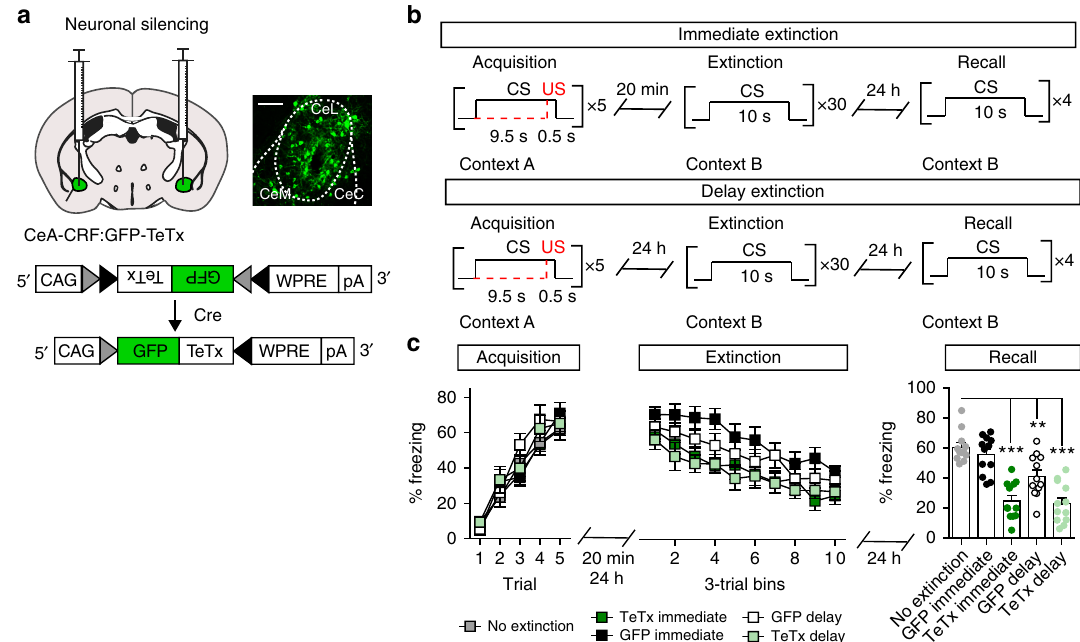
Fig. 1 CeA – CRF neurons antagonize immediate fear extinction. a Schematic of bilateral injection of AAV1-FLEX-GFP-TeTx into the CeA and representative histological veri fi cation of expression. Scale bar: 250 μ m. CAG cytomegalovirus (C) chicken beta actin exon 1/intron 1 (A) rabbit beta-globin splice acceptor (G) promoter/enhancer, WPRE woodchuck hepatitis virus posttranscriptional regulatory element, pA: bovine growth hormone polyadenylation sequence. b Experimental paradigm: Mice ( n = 12/group) were conditioned with fi ve presentations of an auditory CS that co-terminates with a 0.5 mA foot shock (0.5 s) in context A. During extinction, 30 unpaired CS presentations are delivered 20 min following conditioning in context B (immediate, top) or 24 h after conditioning (delay, bottom). c GFP-TeTx expression in CeA – CRF neurons does not alter acquisition (left) or extinction training (middle), but signi fi cantly enhances fear extinction recall (right) relative to the no ext. group (One-way ANOVA followed by Bonferroni multiple comparisons *** P < 0.001, ** P < 0.01). This effect was not observed in GFP-expressing mice. Data are presented as mean ± Standard Error of the Mean (S.